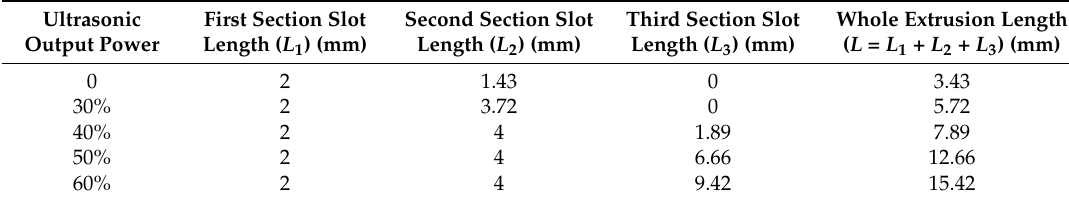
Figure 3. Microphotos of extruded Zr35 alloy ( a ) and recalculated microextrusion lengths of samples at various ultrasonic power outputs ( b ). Table 1. Microextrusion length of Zr35 alloy at various ultrasonic output powers.